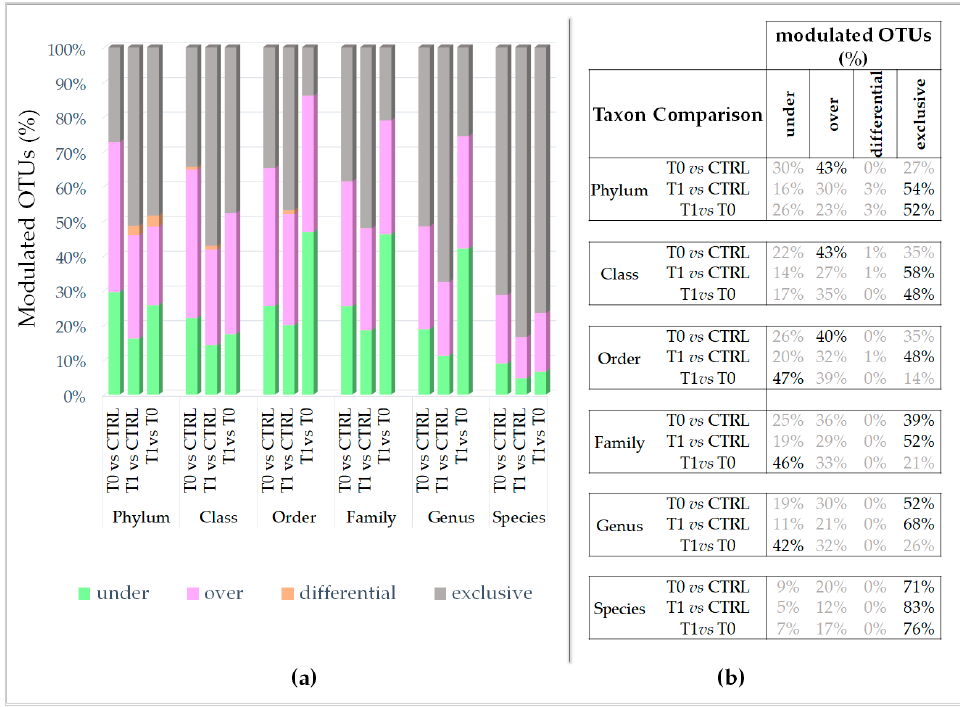
Figure 5. OTU modulation dependence of the taxonomical level. ( a ) Distribution of the under- and over-represented, differential, and exclusive OTUs along the taxonomical levels for all comparisons between microbiotas. ( b ) Abundance (%) of the under- and over-represented, differential, and exclusive OTUs is reported, and the highest abundance for each taxonomical level and comparison is highlighted in bold character .